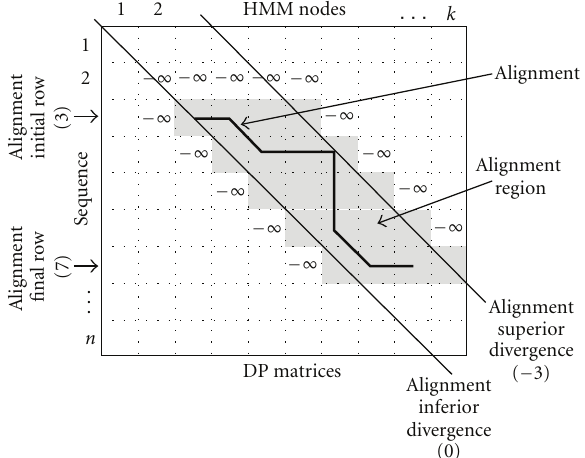
Figure 3: Divergence concept: alignment limits, initialized cells (with −∞ ), and alignment region, for a HMM with k nodes and a sequence of length n